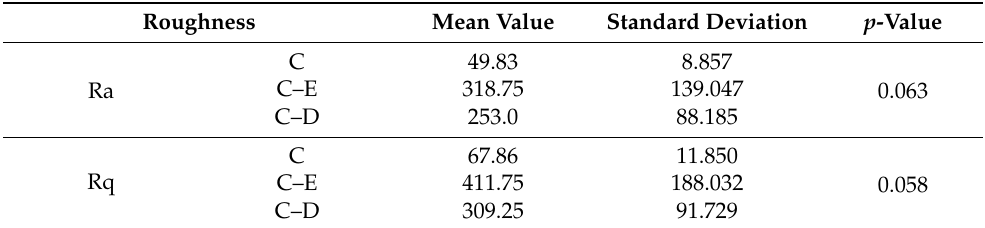
Table 4. Roughness values for the Group A and B